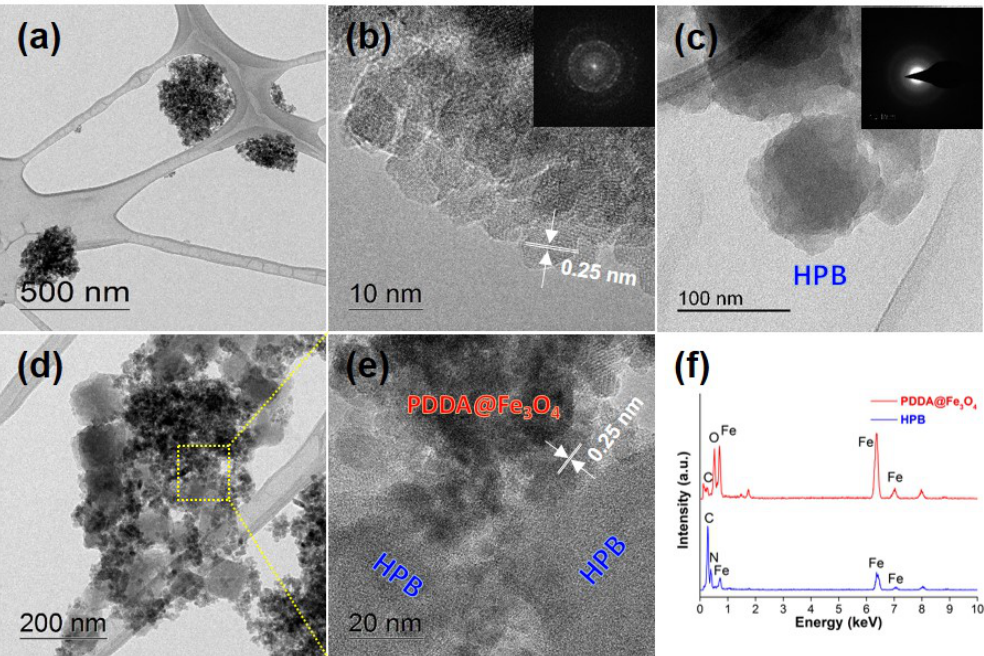
Figure 2. Representative ( a ) TEM and ( b ) HRTEM images of PDDA@Fe 3 O 4 (The inset shows the fast Fourier transform (FFT) pattern of Fe 3 O 4 ). ( c ) HRTEM of HPB nanoparticle (The inset shows selected area electron diffraction (SAED) pattern of HPB). Representative ( d ) TEM and ( e ) HRTEM images of